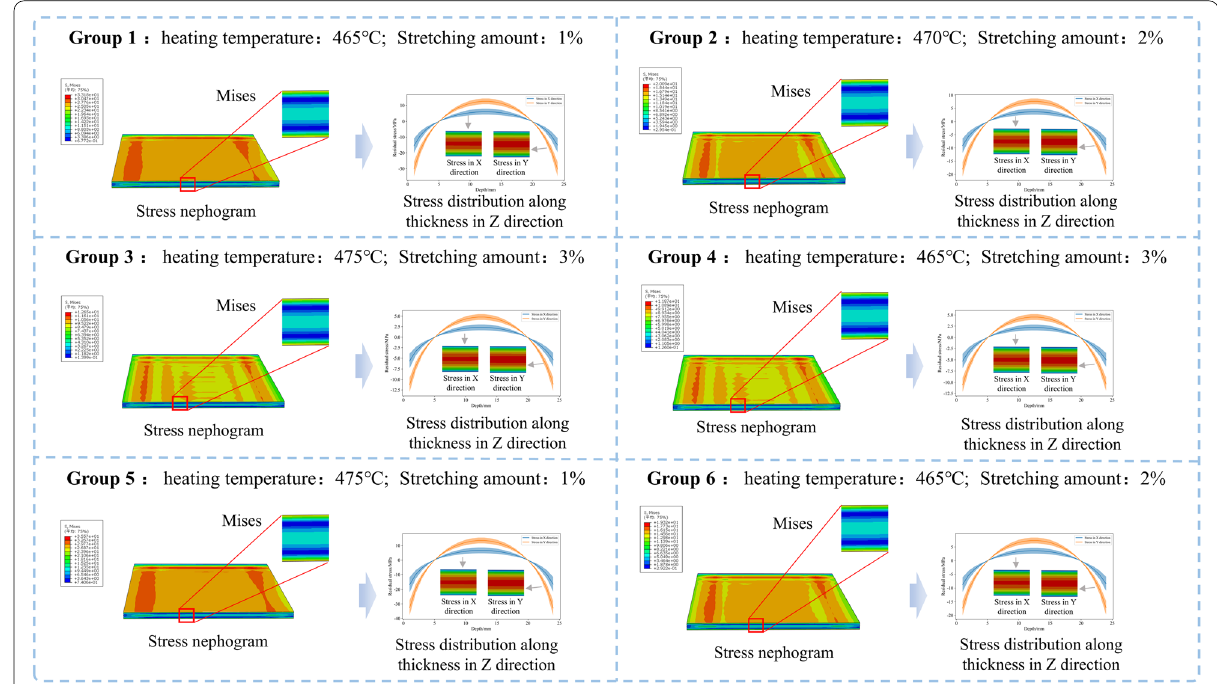
Fig. 8 Preparation parameters and residual-stress distributions of six groups of 7075 aluminum alloy